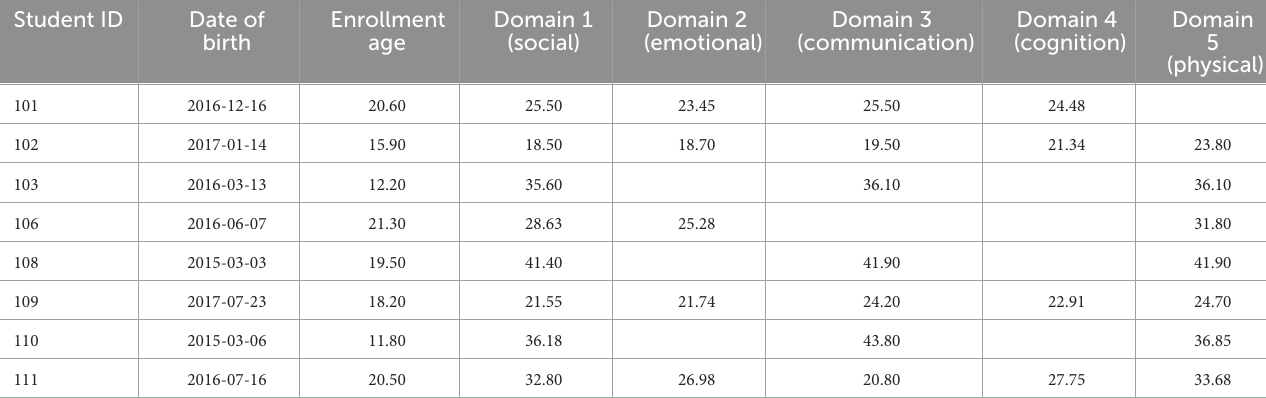
TABLE 2 Average observation ages (months) from each domain.